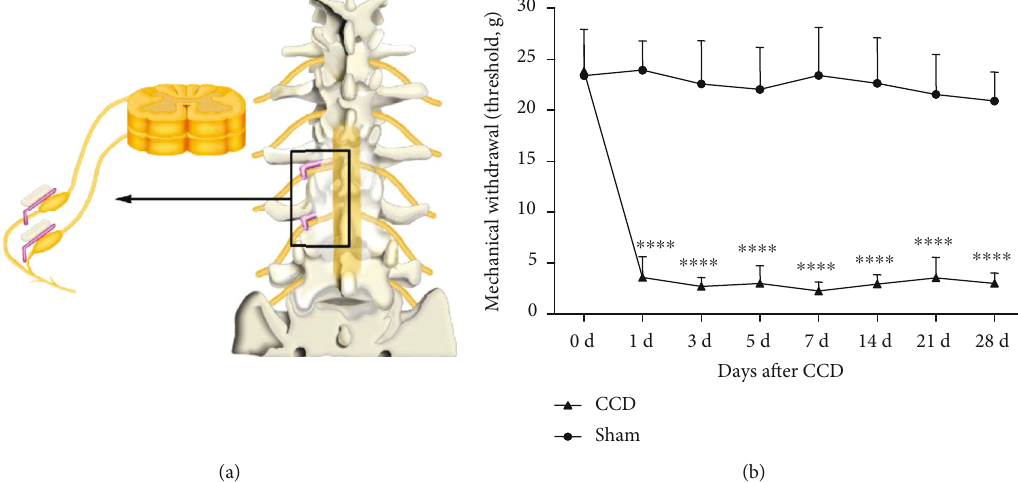
Figure 1: The CCD model and the development of mechanical allodynia after establishment of the CCD. (a) Schematic diagram of CCD generated by inserting stainless steel rod into L4 and L5 intervertebral foramina of rats. (b) CCD-induced mechanical allodynia is manifested by a reduction of MWT. Bars represent group means ± SD , n = 12 per group. Two-way ANOVA, ∗∗∗∗ P < 0 : 0001 versus